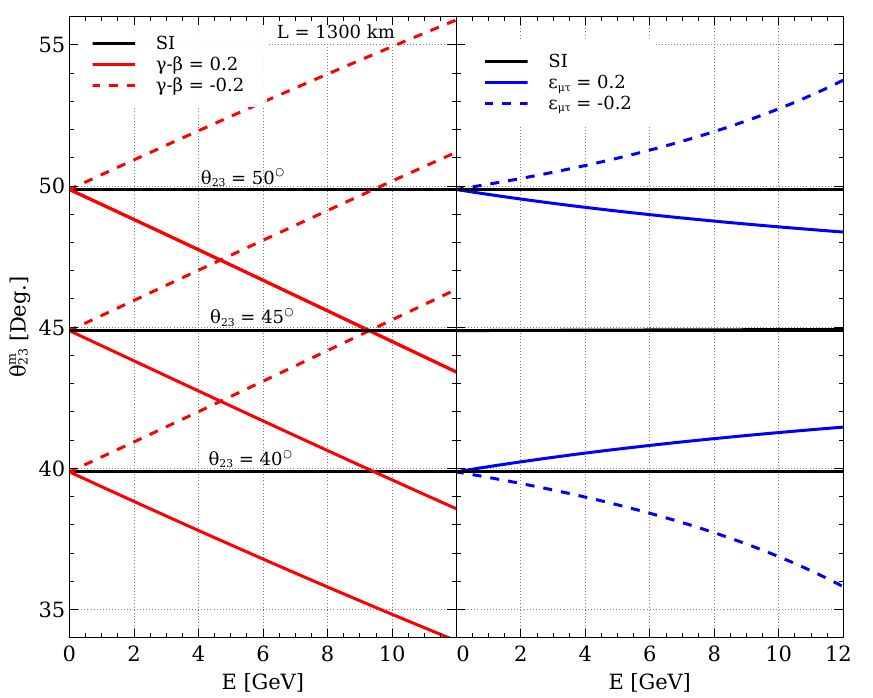
in matter (given in eq. (3.9)) as a function of neutrino energy in the Figure 1 . Evolution of θ m 23 presence of SI and SI+NSI. Solid black curve in each panel represents the SI case while the other curves correspond to the SI+NSI cases with positive (solid lines) and negative (dashed lines) values of NSI parameters. In the left column, we show the modification in the presence of NSI parameter ( γ − β ) , while the right column depicts the effect of ε . We consider L = 1300 km and assume NMO. µτ We present results for three different values of θ in vacuum: 40 ◦ (lower octant), 45 ◦ (maximal value), 23 50 ◦ (upper octant). The values of the other oscillation parameters in vacuum are taken from table 2. experiment i.e. 1300 km. The left column shows the effect of NSI parameter ( γ − β )